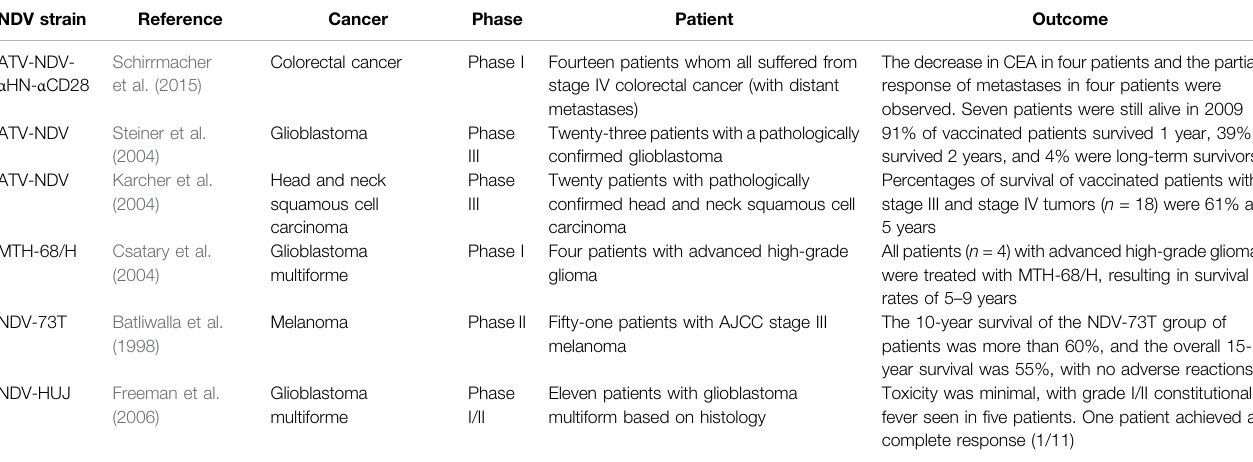
TABLE 2 | NDV strains for different cancer treatments in clinical